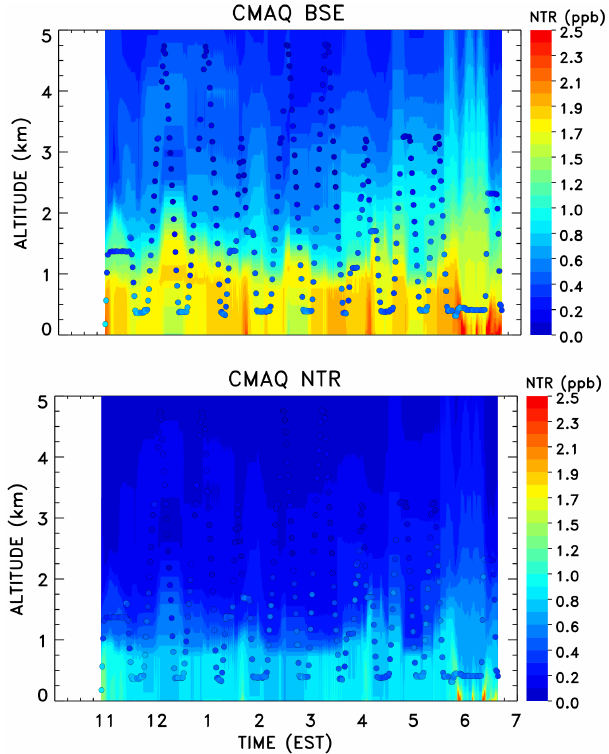
Figure 4. (Top panel) Comparison of baseline CMAQ simulations of organic nitrates (NTR) (colored contours) to NTR observed dur- ing the DISCOVER–AQ field mission on 29 July 2011 (colored points). (Bottom panel) As in the top panel, except the CB05 chem- ical mechanism in CMAQ has been modified such that the lifetime of NTR is reduced by a factor of 10.